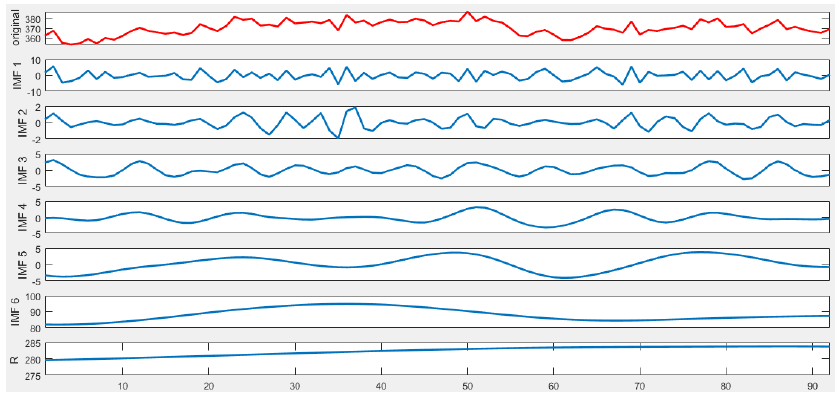
Figure 5. The IMFs (intrinsic mode functions) of CEEMDAN.